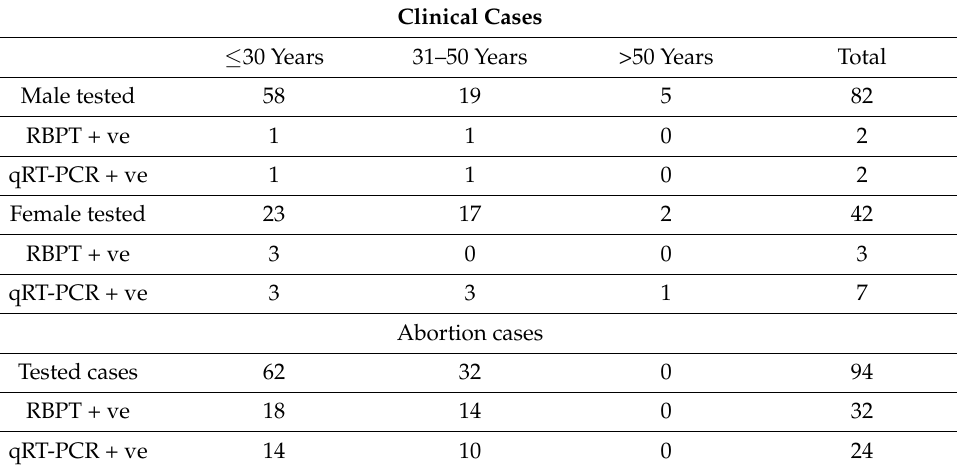
Table 2. The relation between results of serology and molecular diagnostics and age of patients in samples collected from 218 fever of unknown origin (FUO) patients from six different hospitals in the Lahore district of